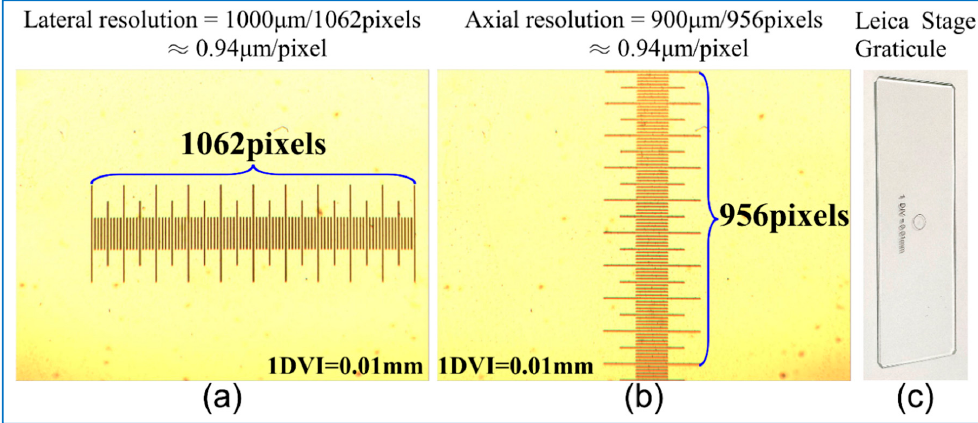
Figure 4. ( a ): The calculation of the lateral resolution; ( b ): the calculation of the axial resolution; ( c ): Leica Stage Graticule.